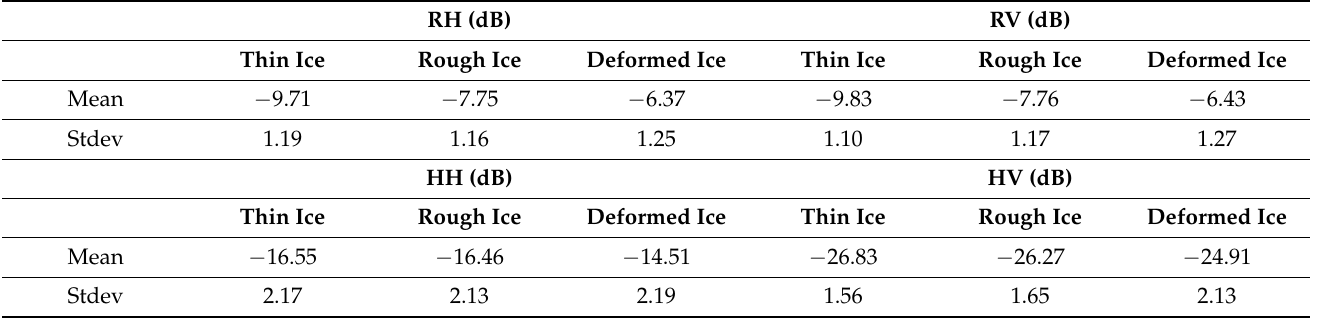
Table 4. Mean and Standard Deviation of Sea Ice Types in RCM and RADARSAT-2 Images.